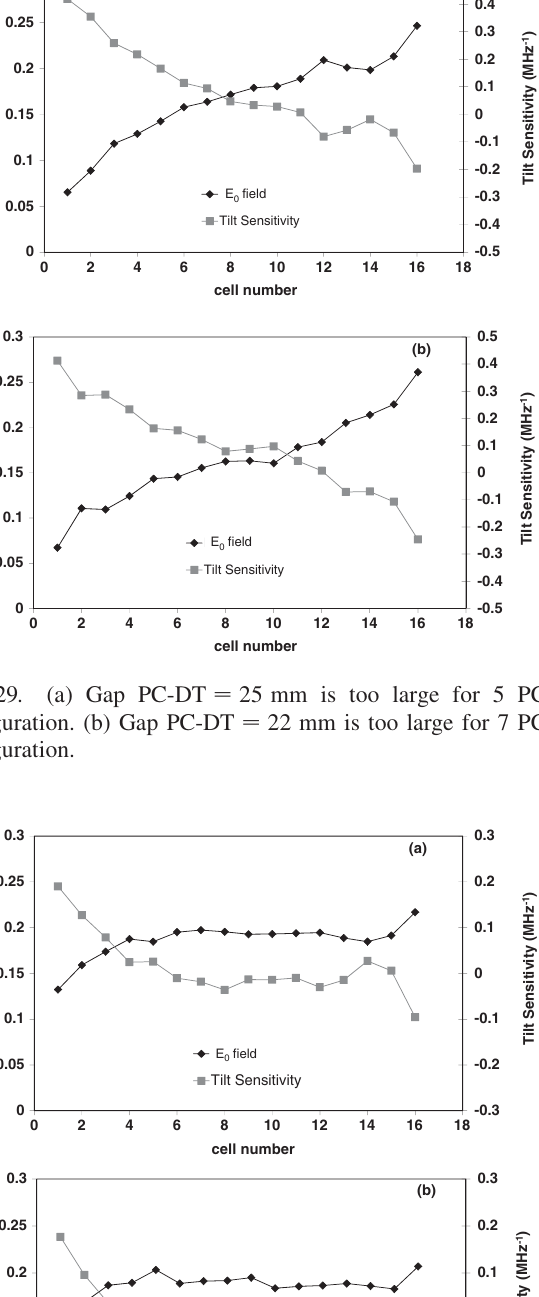
TABLE II. Optimum PC settings for DTL cold model at ¼ 22 : 5 mm , as pc ¼ 19 mm , as calculated by pc